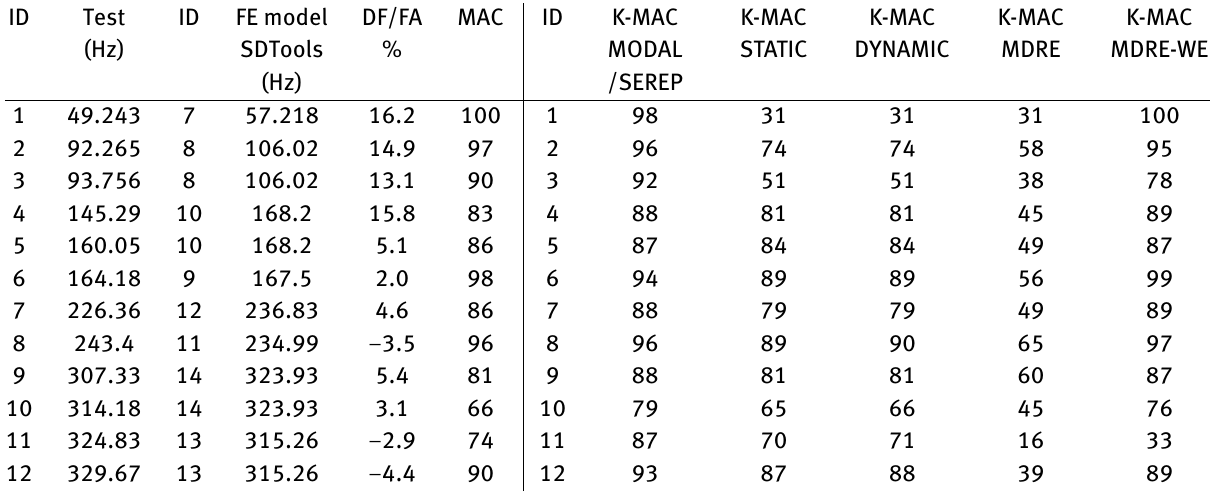
Table 4: Comparative MAC: Updated full model (SDTools) and K-MAC MSE results vs. experimental measurements.